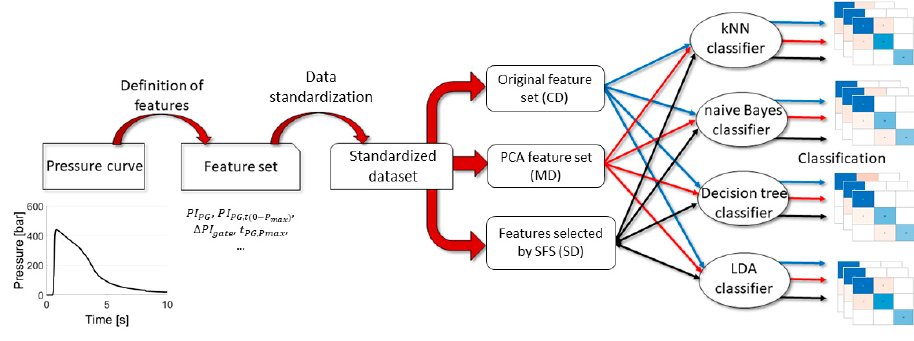
Figure 6. The schematic representation of the classification